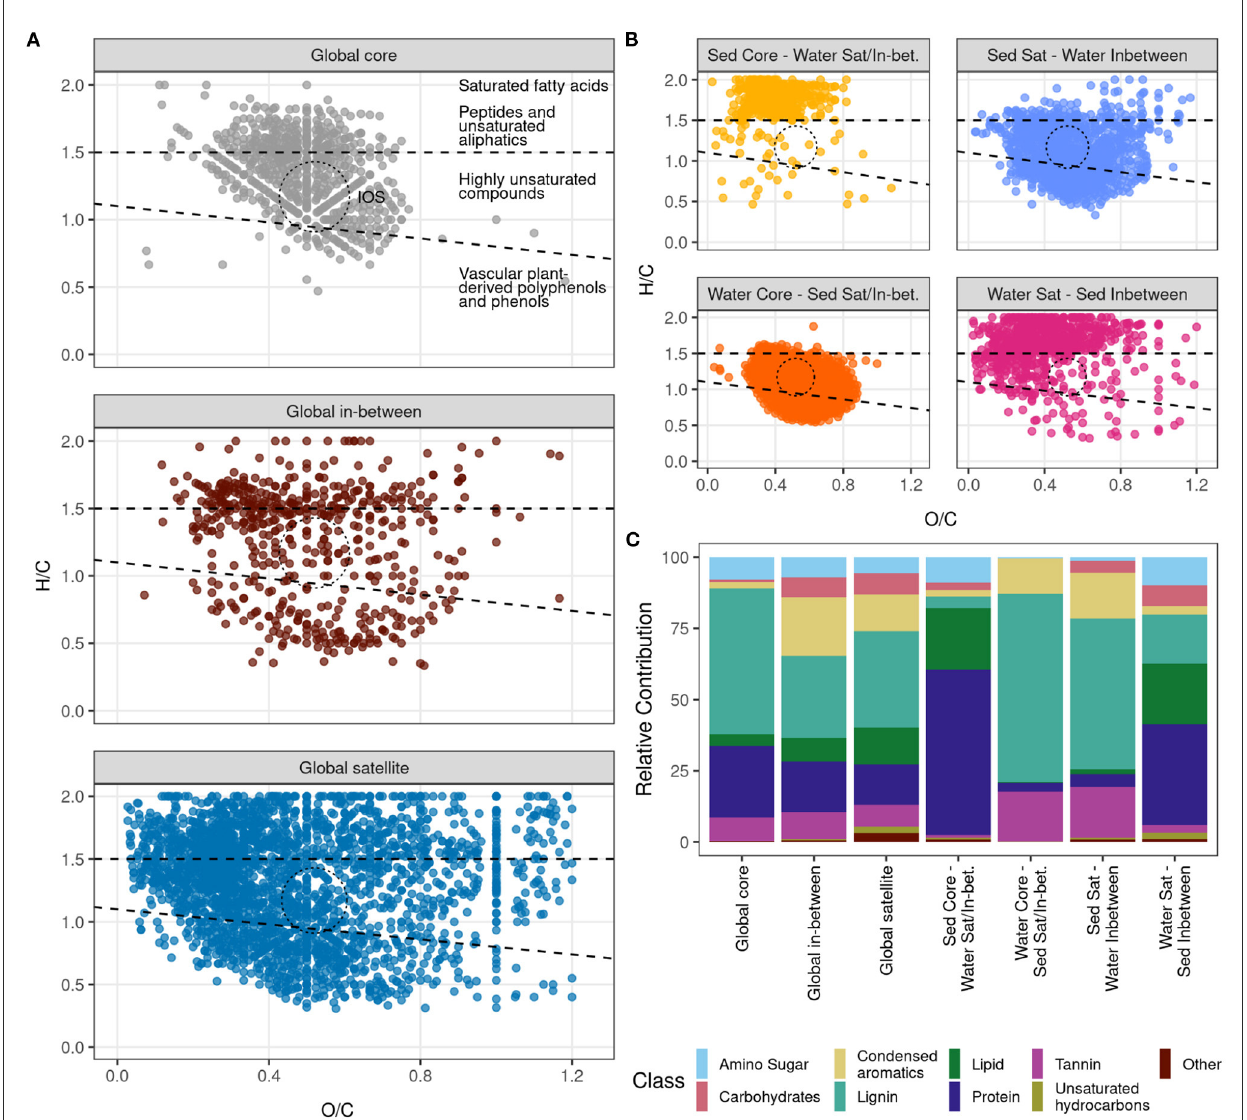
FIGURE3 Cross-environmental groups identify common and different molecular formulae between sediment and surface water. (A) Van Krevelen diagram of molecular formulae with common occupancy across environments. (B) Van Krevelen diagram of molecular formulae that change occupancy dependent on environment. (C) Relative contribution of each cross-environmental group in terms of chemical classes. IOS = island of stability.